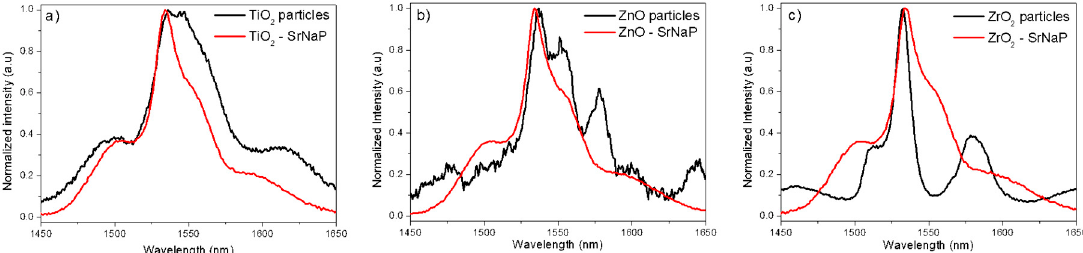
Figure 5. Emission spectra of the Er 2 O 3 -doped TiO 2 ( a ), ZnO ( b ), and ZrO 2 ( c ) particles and of their corresponding particles-containing SrNaP glasses.